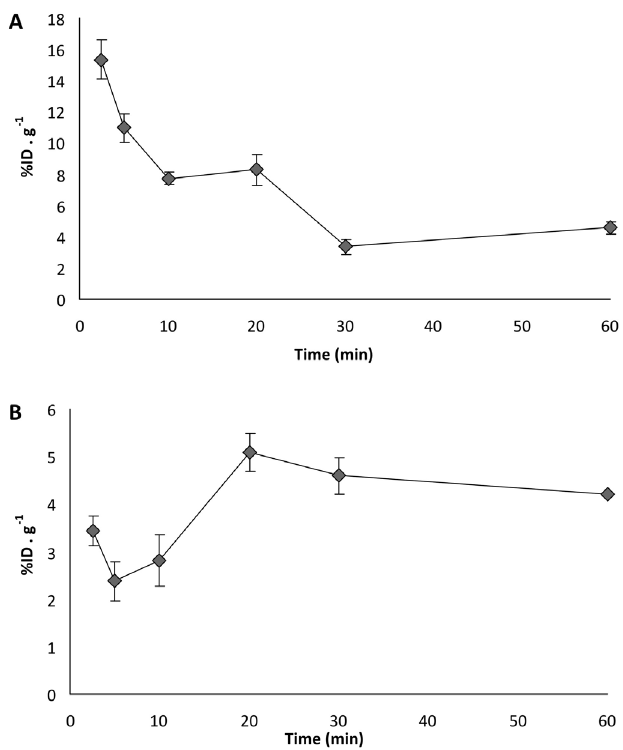
FIGURE 6 - Na 18 F kinetics in blood (A) and bone (B).